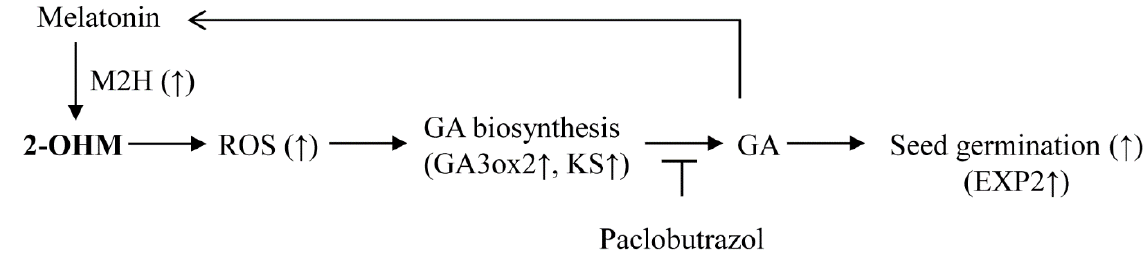
Figure 8. Schematic model showing 2-hydroxymelatonin (2-OHM)-mediated seed germination en- hancement in A . thaliana seeds. Seed imbibition induced melatonin 2-hydroxylase ( M2H ) expression, leading to 2-OHM synthesis, which triggered reactive oxygen species (ROS) production followed by gibberellic acid (GA) biosynthesis, resulting in increased seed germination. Paclobutrazol treatment nullified 2-OHM-mediated seed germination enhancement. GA was positively involved in the synthesis of melatonin, which acts as a substrate for the M2H enzyme in 2-OHM biosynthesis. Upward arrows indicate upregulation. GA3ox2 , gibberellin 3-oxidase 2 ; KS , ent-kaurene synthase; EXP2 , expansin 2.